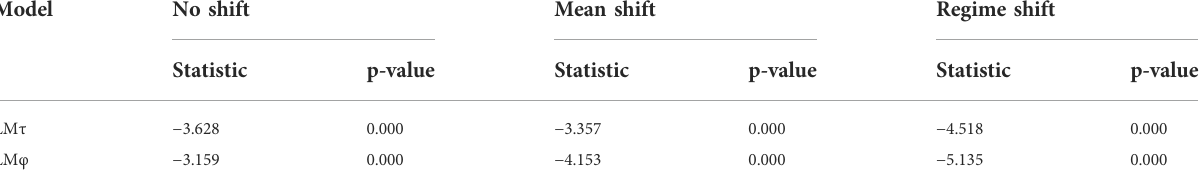
TABLE 5 Cointegration test.